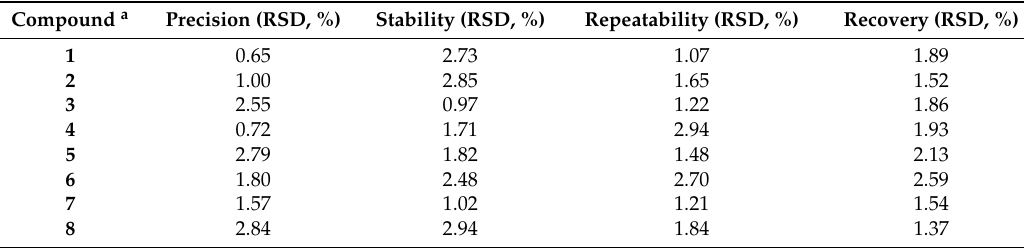
Table 4. The results of the precision, stability, repeatability, and recovery tests.